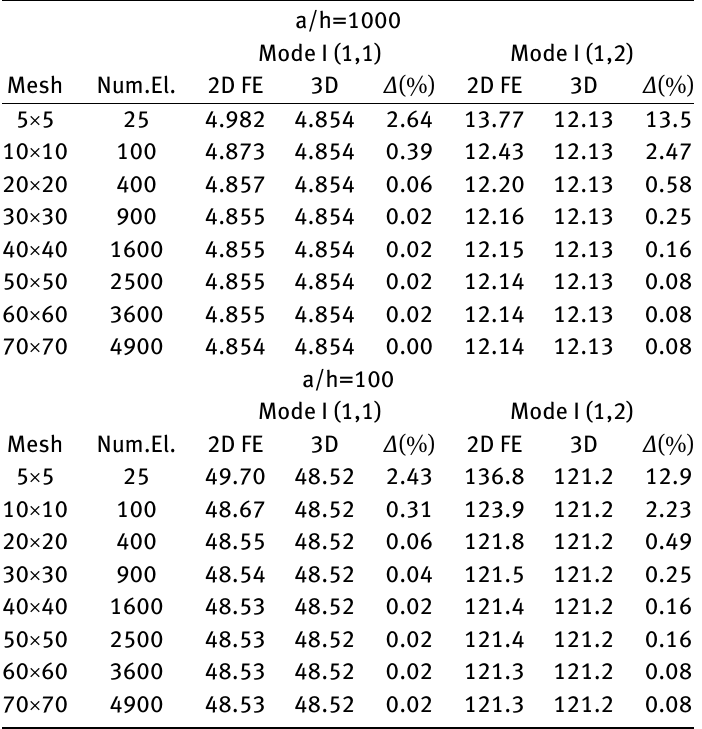
Table 5: First assessment for the 2D FE solution, simply supported plate made of aluminium alloy with thickness ratios a/h=1000 and a/h=100. First two frequencies in Hz, comparison between the present 3D exact solution and the 2D FE solution via Nastran. The error is calculated as ∆ (%) = FE −3 D × 100 3 D